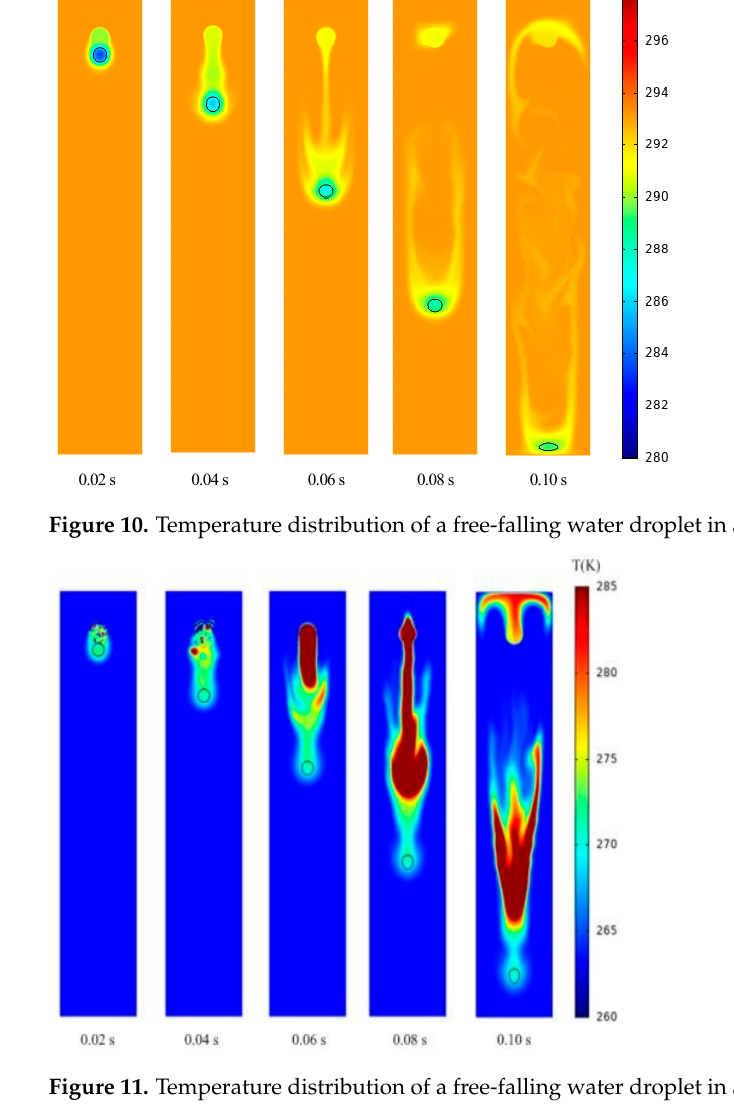
Figure 11. Temperature distribution of a free-falling water droplet in air at 263.15 K.